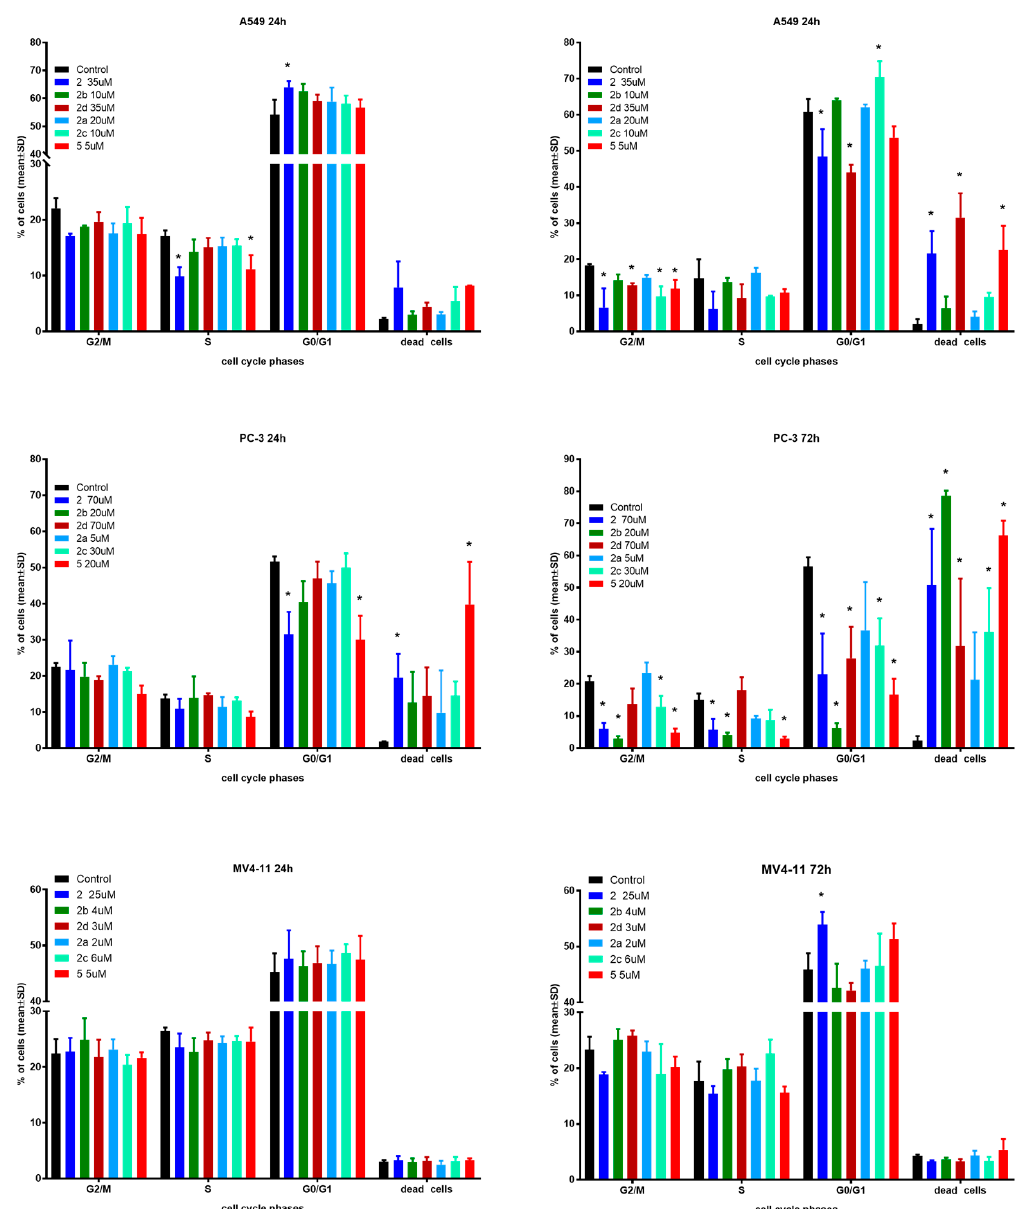
Figure 3. Influence of tested compounds on cell cycle after 24 and 72 h incubation. * statistically significant versus control cells, p < 0.05. Compounds were tested in concentrations of about 1 × IC 50